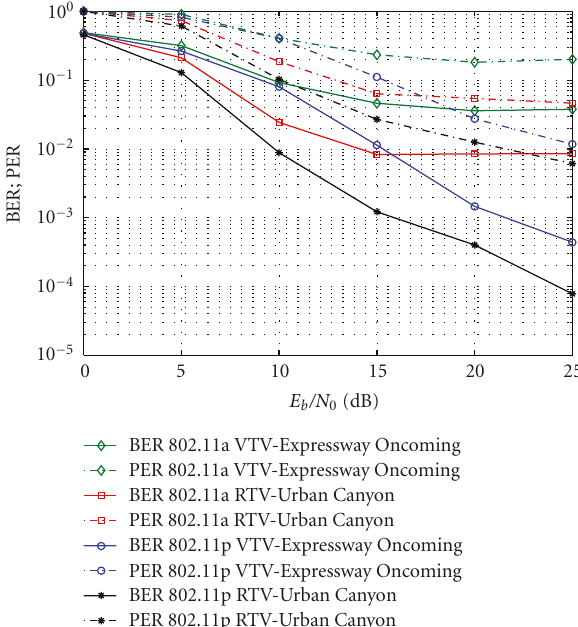
Figure 14: BER/PER comparison between IEEE 802.11p and IEEE 802.11a when transmitting over the channel